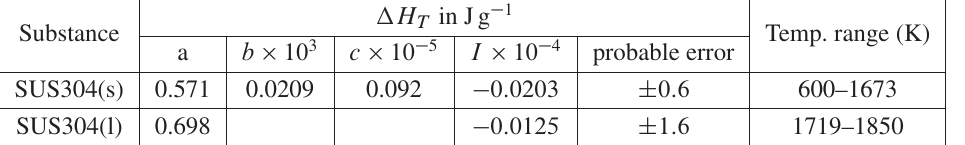
Table 2. Heat content of SUS304 stainless steel (cid:2) H T D aT C bT 2 C cT (cid:3) 1 C I. Solidus Liquidus Enthalpy of